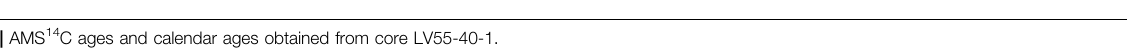
TABLE 1 | AMS 14 C ages and calendar ages obtained from core LV55-40-1. Laboratory